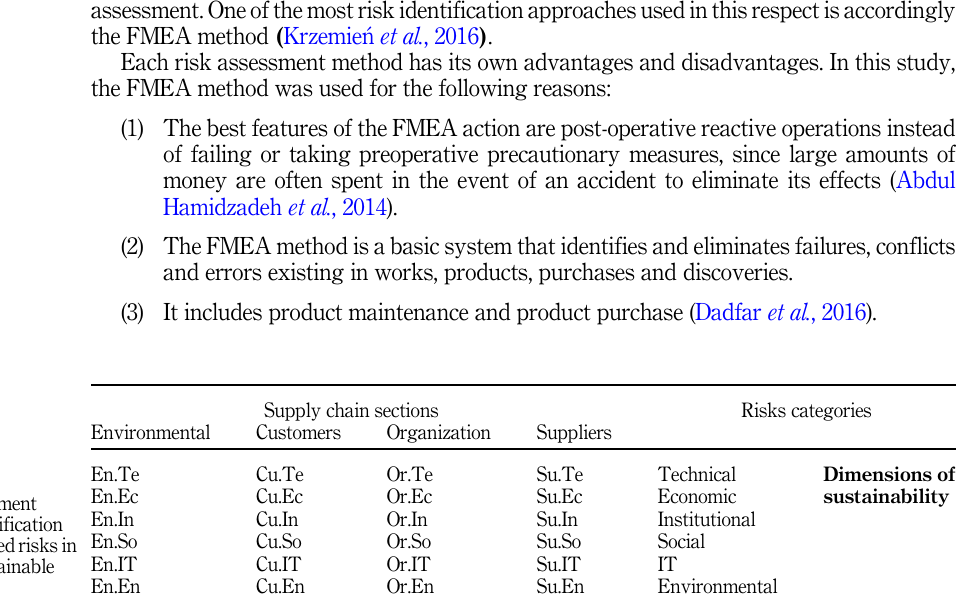
Table 1. Risk management matrix- Classification oftheidentifiedrisksin terms of sustainable